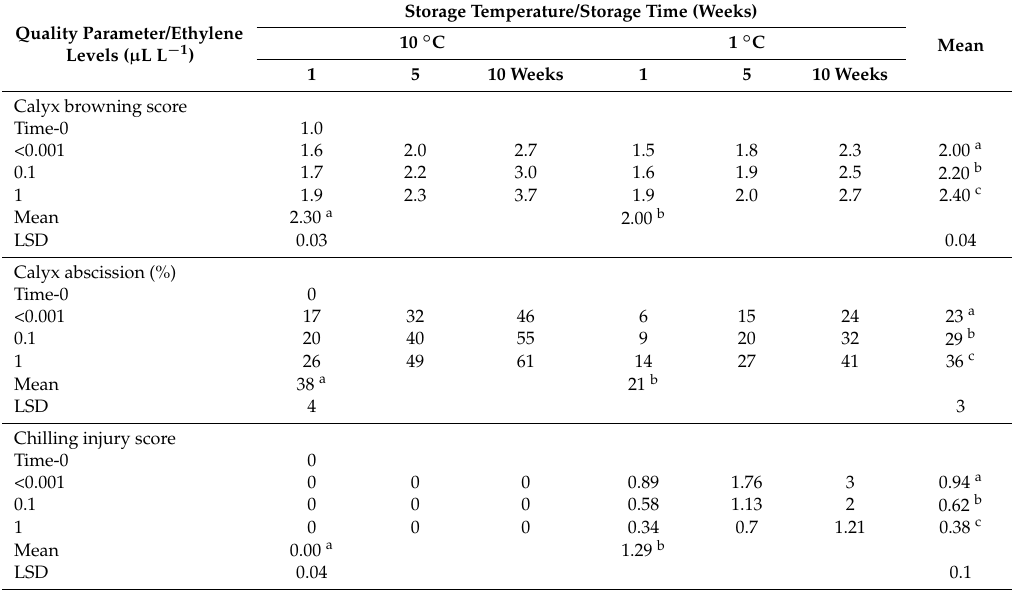
Table 2. Calyx browning, calyx abscission and chilling injury of Navel oranges stored at 10 and 1 ◦ C. Quality Parameter/Ethylene Levels ( µ L L − 1